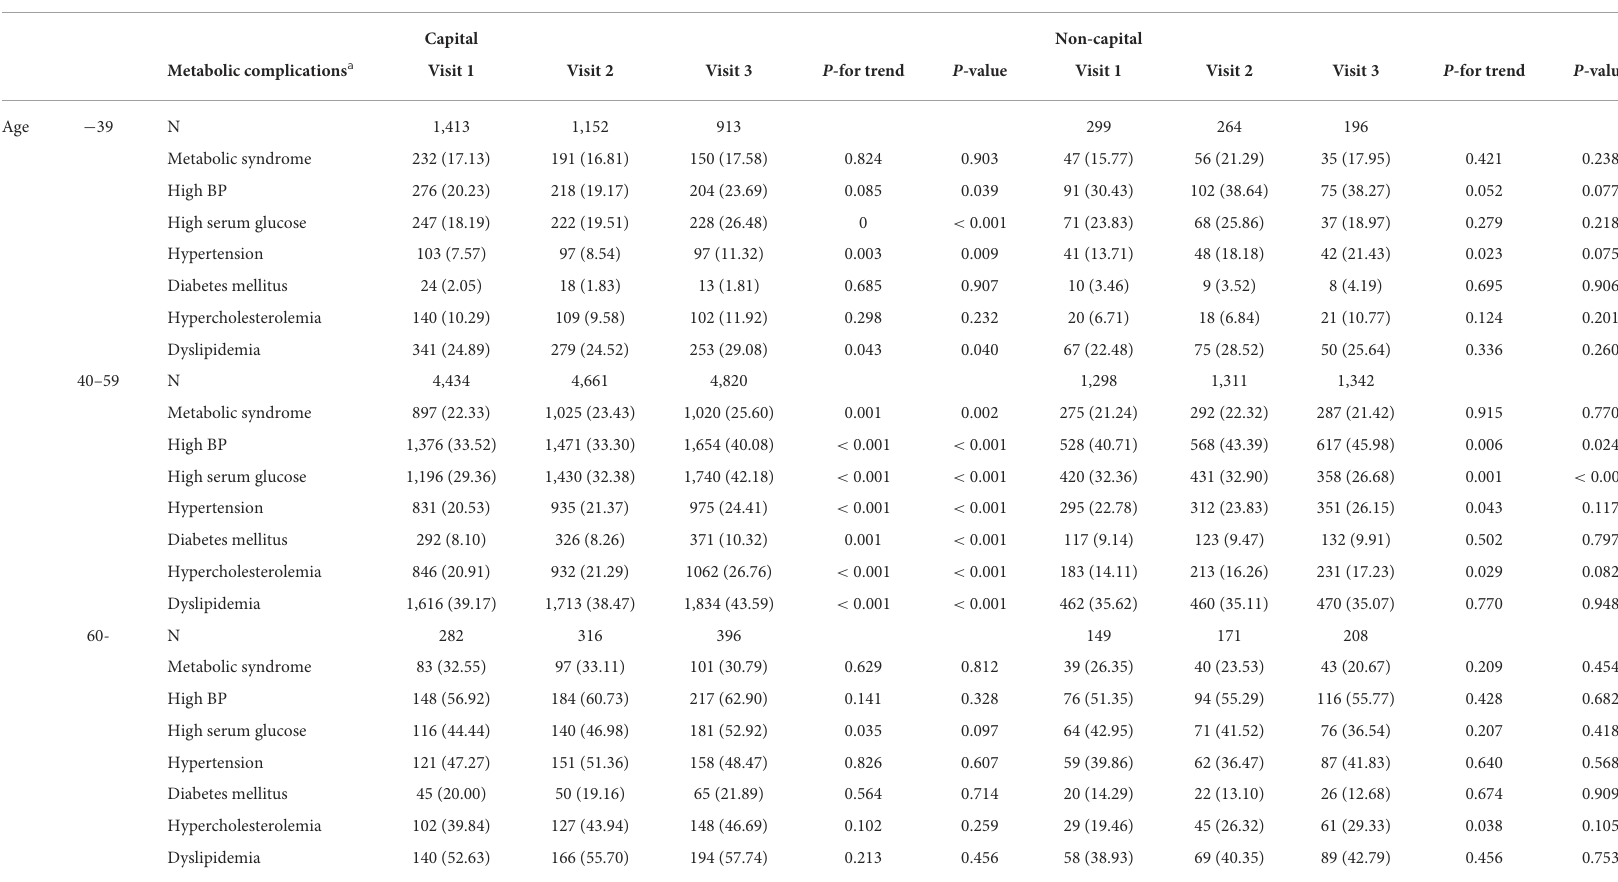
TABLE 3 Prevalence of metabolic complications at each visit according to age group and health check-up center location.